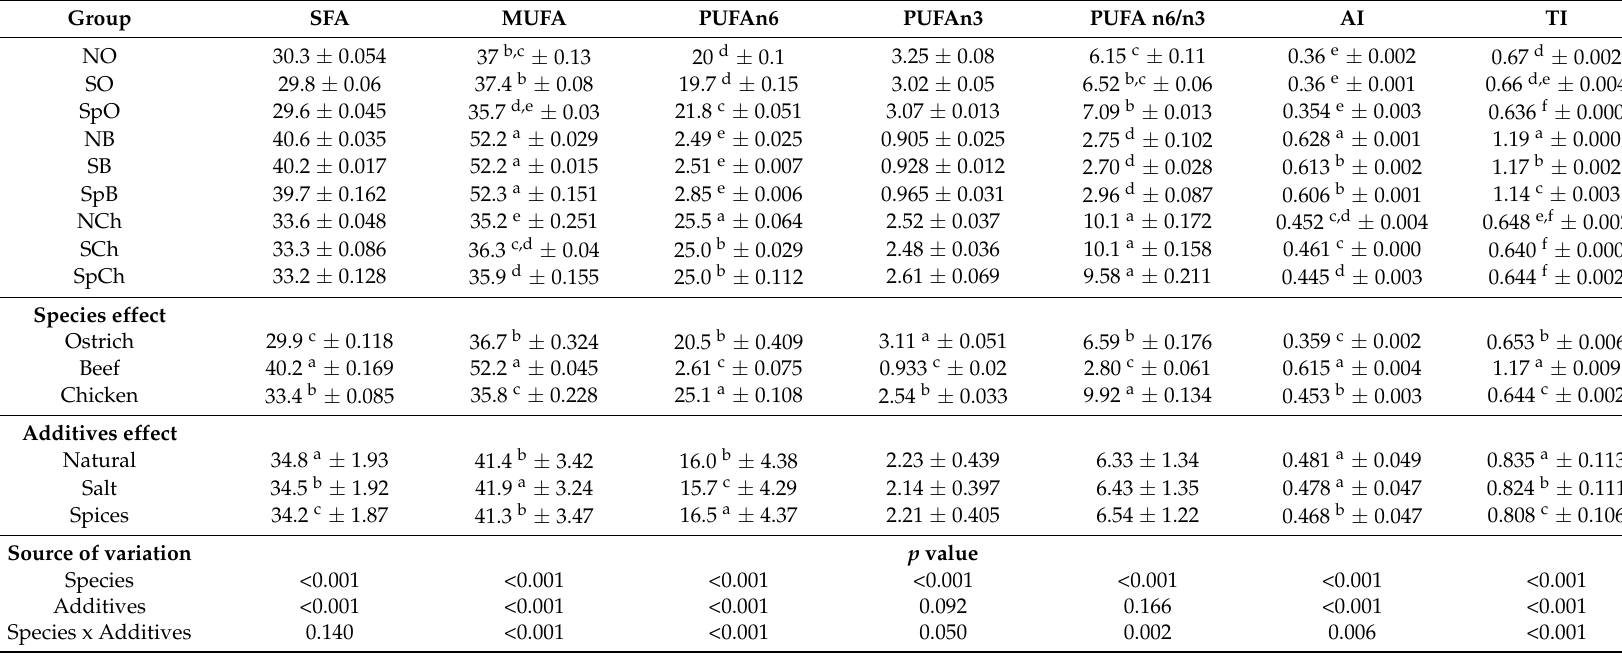
Table 5. Sum of fatty acid, atherogenic index (AI) and thrombogenic index (TI) in dried meat (%) (mean ±